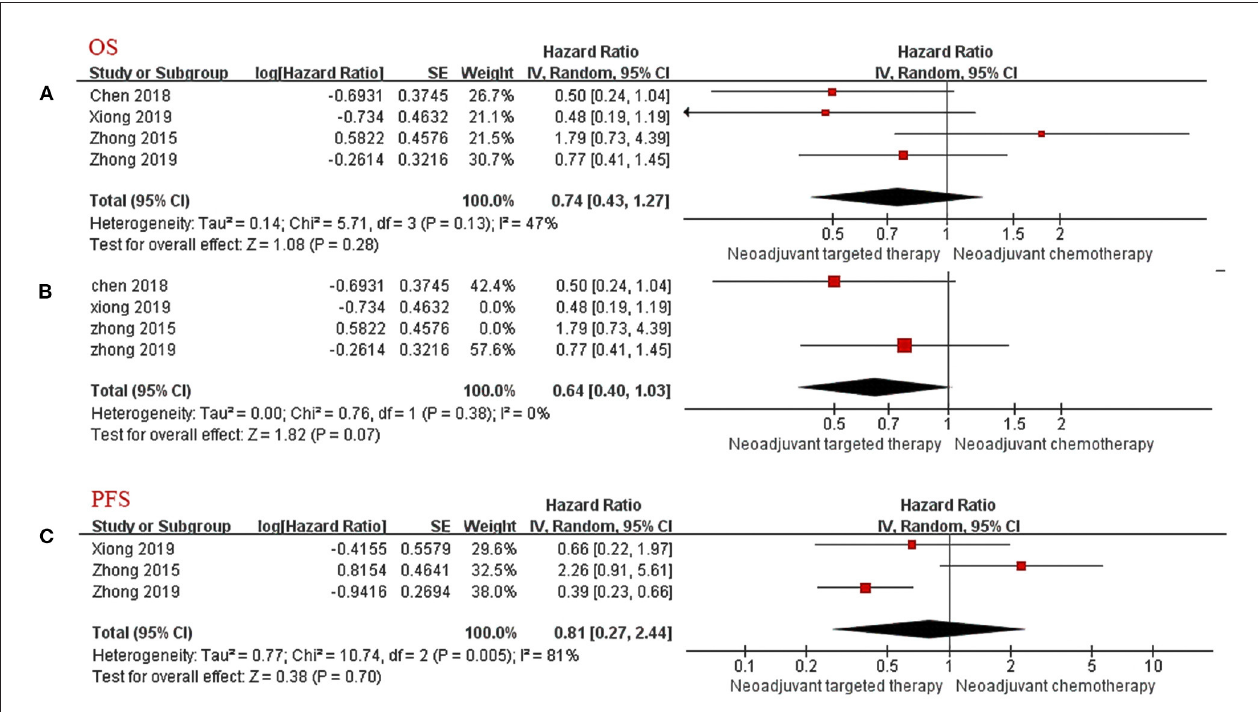
FIGURE 2 | Forest Plot for Overall Survival (A,B) and Progression-Free Survival (C) . CI, confidence interval; HR, hazard ratio; SE, standard error. a HR < 1 meant a better prognosis in the experimental group (NTT). b I ² < 25% can choose fixed effect model, otherwise choose random effect